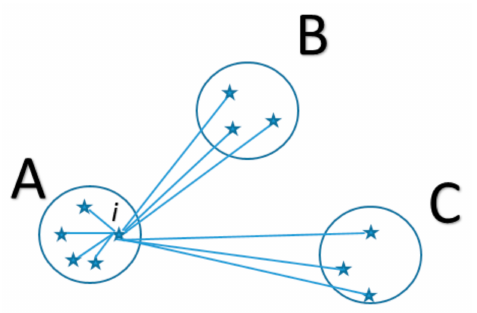
Figure 2. The general idea of the silhouette index, where object i belongs to cluster A